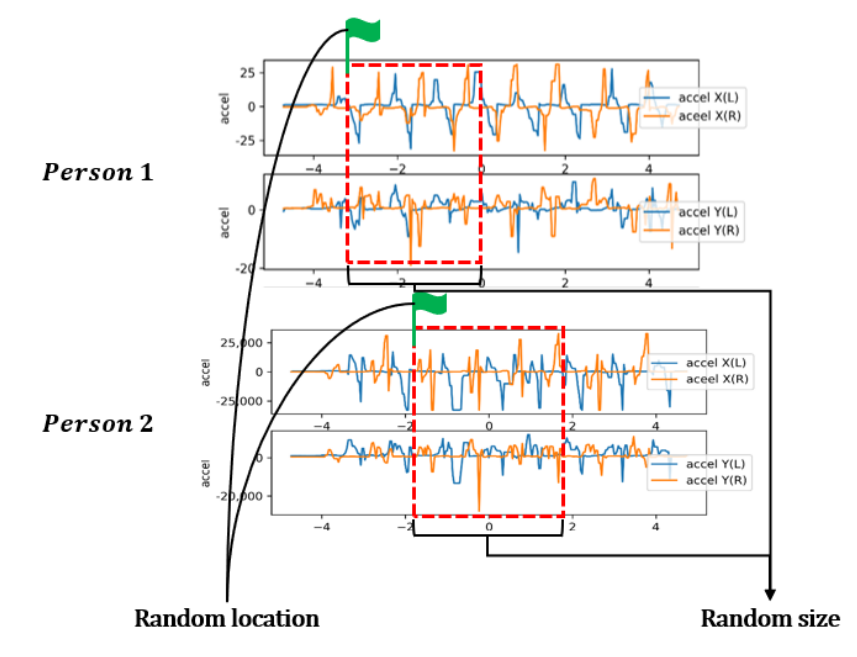
Figure 7. Data selection with a random location and a random size.